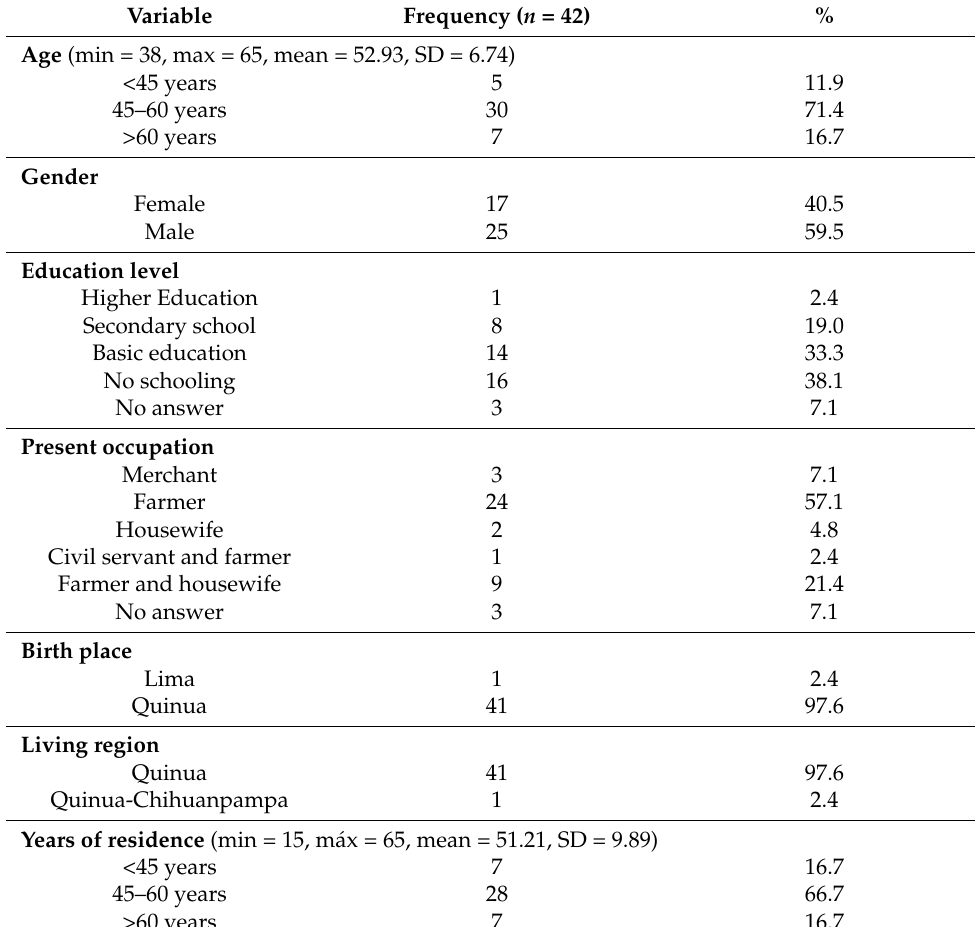
Table 1. Socio-economic profile of the surveyed villagers in Quinoa